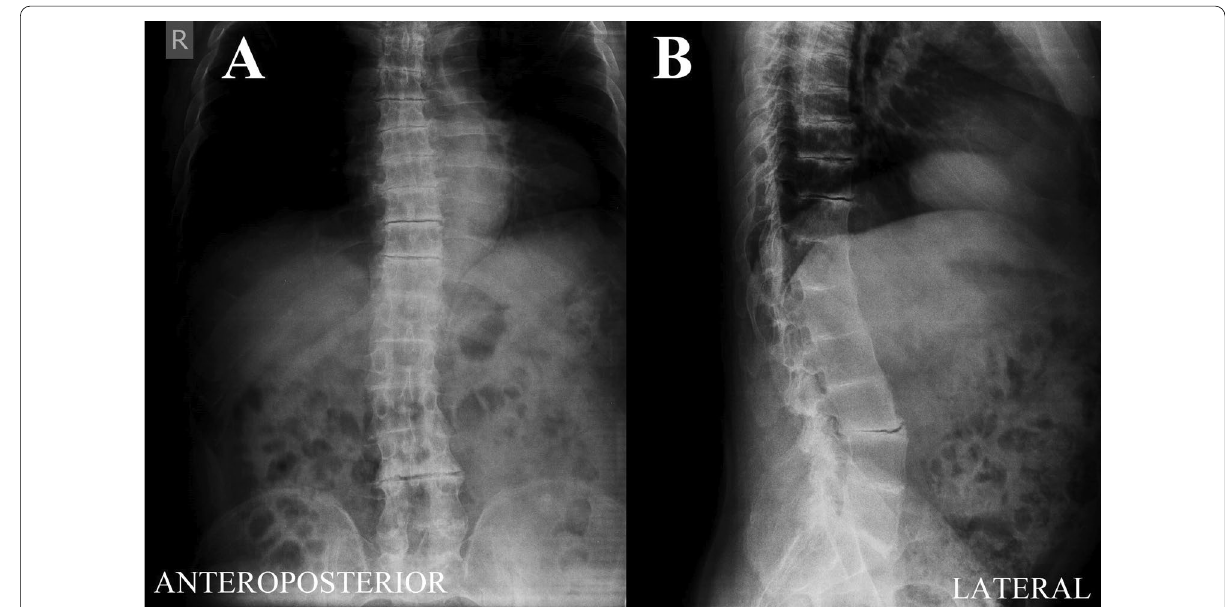
Fig. 3 Anteroposterior ( A ) and lateral ( B ) Plain radiographs of the dorsal and lumbar spine showing osteopenia and calcification of the intervertebral